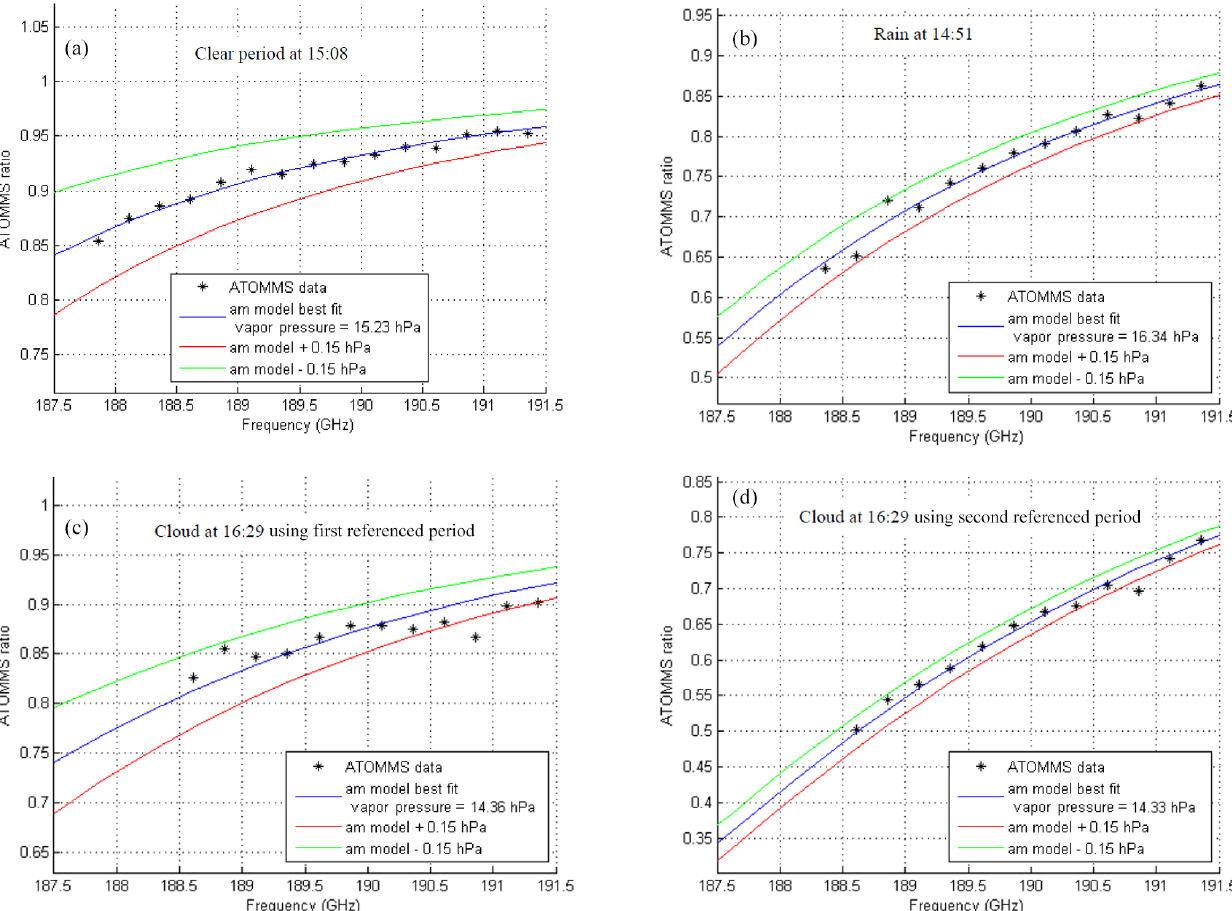
Figure 5. Examples of fitting the observed ATOMMS amplitude ratio, Eq. (2) (black asterisks), to the forward calculated ATOMMS ratio using am7.2. Blue line is the best-fit line for the indicated vapor pressure. Red line is am forward calculation for a vapor pressure 0.15hPa greater than the best-fit vapor pressure. Green line is forward calculation for a vapor pressure 0.15hPa less than the best-fit vapor pressure. The solutions shown in panels (a) , (b) and (c) used reference period 1, while the solution in (d) used reference period